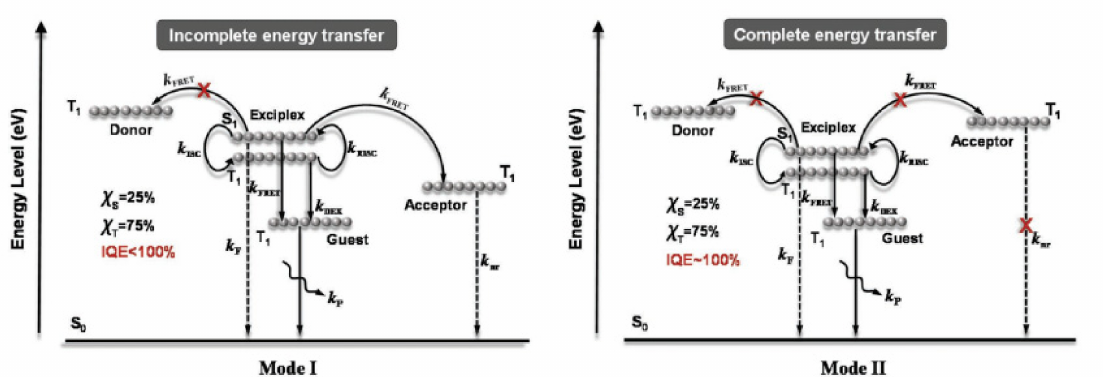
Figure 15. Two different energy-transfer modes. Donor and acceptor are the constituting molecules for exciplex. S 1 and T 1 are the singlet and triplet states, respectively. k FRET , k DEX , k ISC , k RISC , k F and k P are the rate constant of Förster energy transfer, Dexter energy transfer, ISC, RISC, fluorescence and phosphorescence processes, respectively. Left: Incomplete energy transfer. Right: Complete energy transfer. Reproduced with permission from [36], John Wiley and Sons,